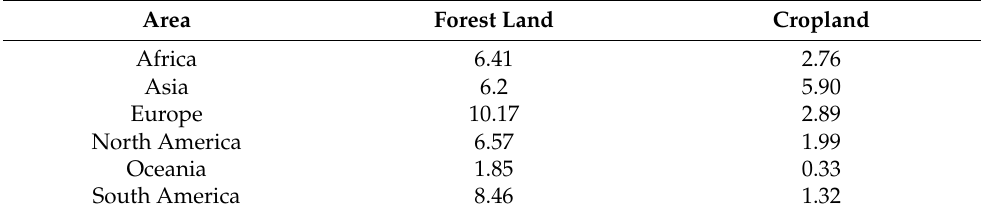
Figure 1. Production volume of wood ‐ based panels from 2000–2019 worldwide [19]. Table 1. Forest land vs. cropland area in the world in 2019 (million km 2 , [19]). Area Forest Land